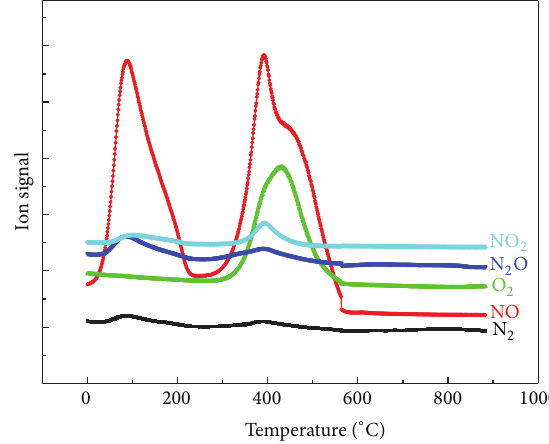
Figure 8: TPD profiles in flowing He after NO and O 2 coadsorption over the In/HZSM-5/In 2 O 3